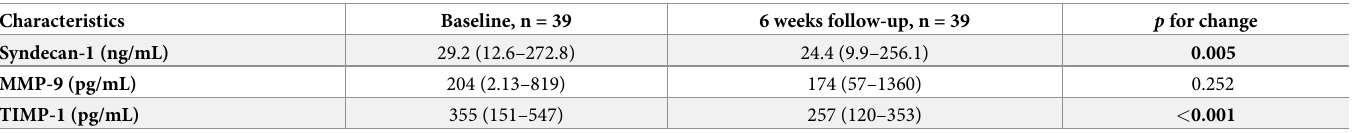
Table 2. Changes in syndecan -1, MMP-9 and